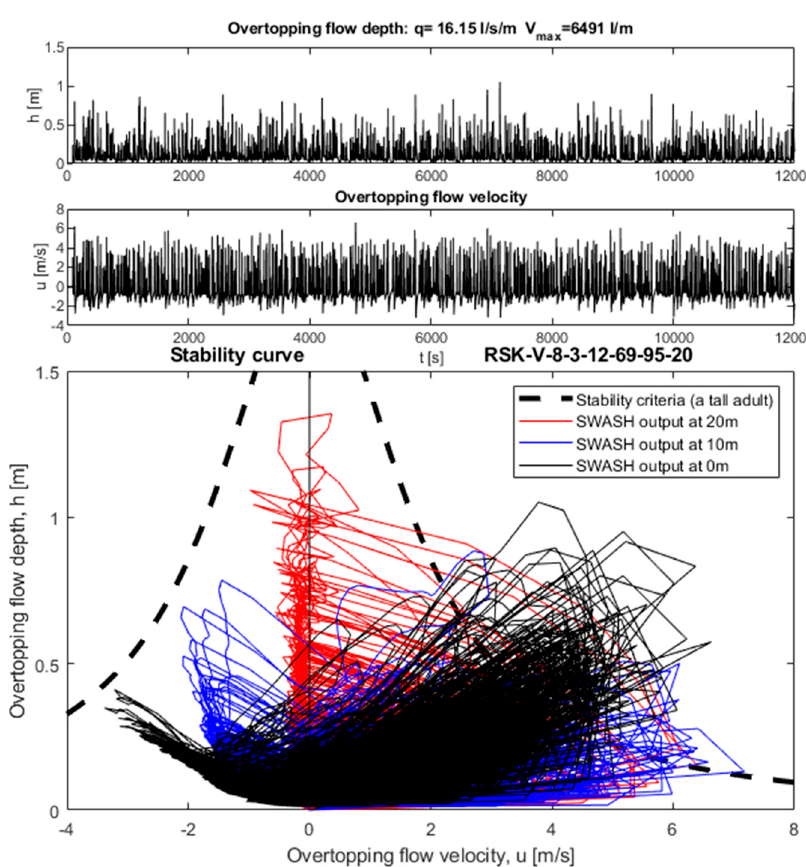
Figure 10. Time series of h and u (the first and second figures) and h-u relationship calculated in SWASH versus the stability curve of a tall adult (the third figure) at 3 output points: RSK_W_8_3_12_69_95_20 (a vertical wall case corresponding to the case in which V is around 6500 l/s/m, and the promenade width of 20 m).